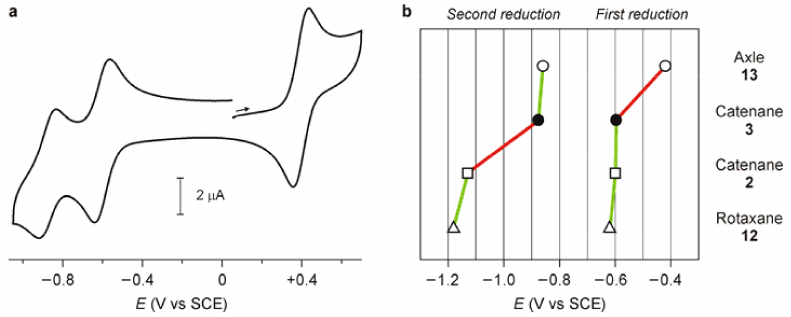
Figure 5. Electrochemical measurements: ( a ) Cyclic voltammogram of an argon-purged acetonitrile solution of catenane 3 (0.03 mM, 0.04 M tetraethylammonium hexafluorophosphate (TEAPF 6 ); scan rate 200 mV s − 1 ); the wave in the region of positive potentials is that of ferrocene used as an internal standard. ( b ) Genetic diagram for the first and second reduction processes for (from top to bottom): the free bipyridinium axle 13 (empty circles), the [2]catenane 3 (solid circles), the one-station [2]catenane 2 (squares); and the one-station [2]rotaxane 12